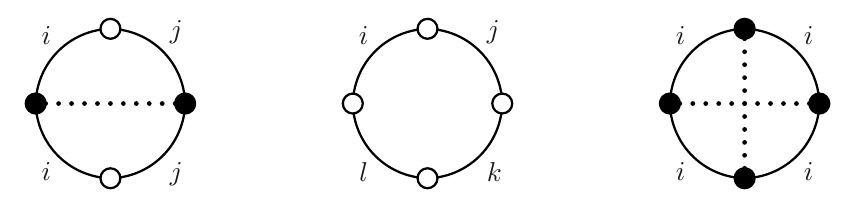
Figure 1 . Covariant diagrams for the covariant derivative expansion at order n =